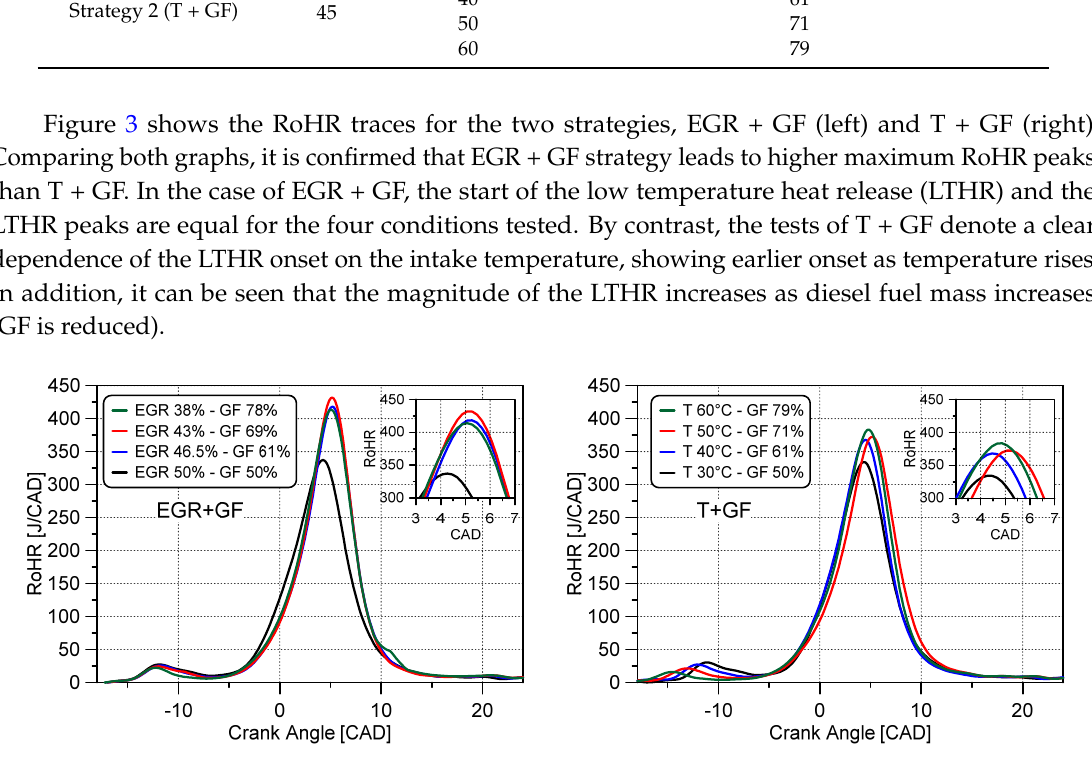
Figure 3. RoHR traces for the experiments with both strategies: EGR + GF (left) and T + GF (right) at 7.5 bar IMEP and 1200 rpm.